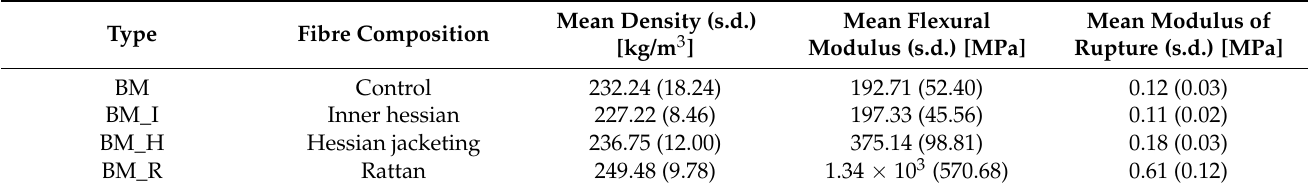
Table 2. Summary of specimen types parameters, resulting dried densities, and flexural